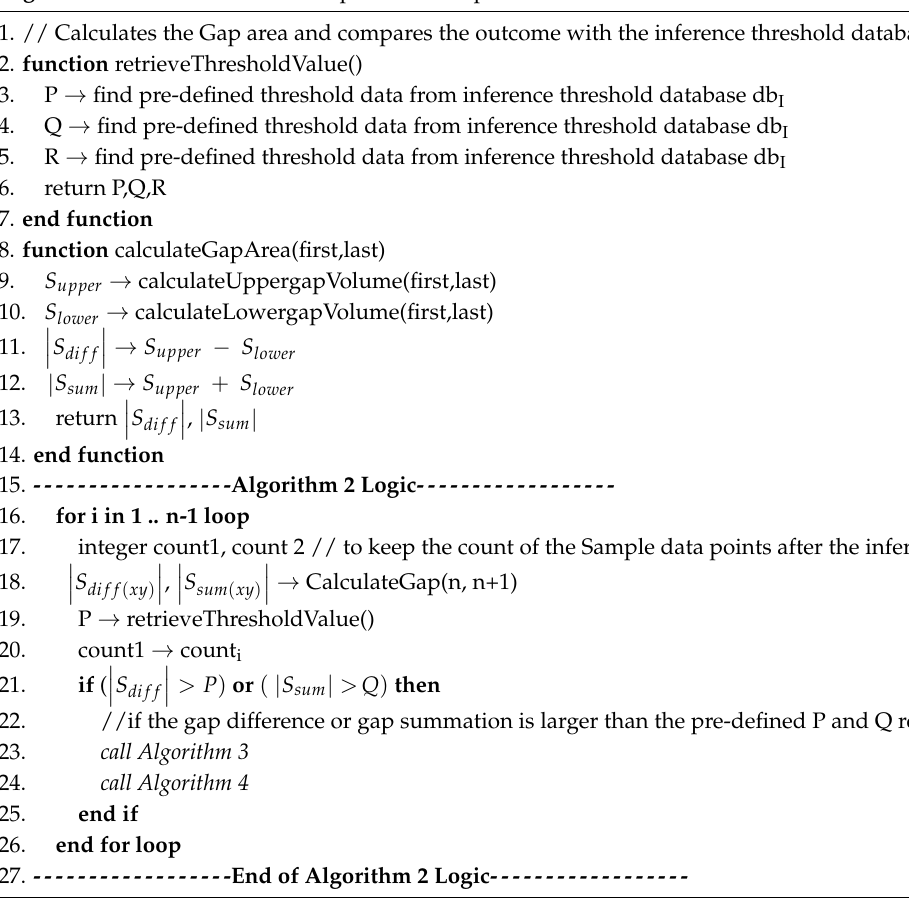
Algorithm 2. Calculation and comparison of Gap area